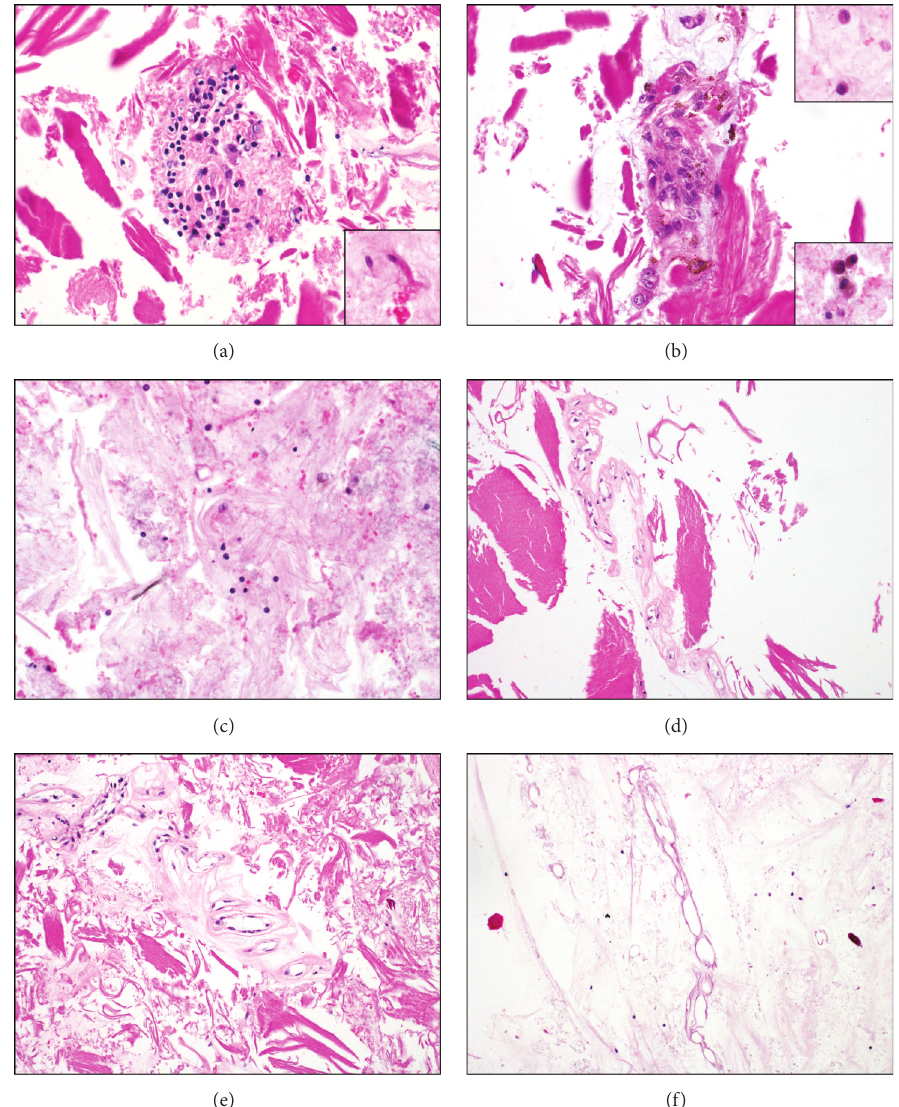
Figure 2: (a) Fragments of a group of spindle cells in type 2 matrix background. Inset shows isolated spindle cells (H&E, 40x). (b) Group of histiocytes and RPE cells in a granulomatous-like structure. Superior inset: isolated macrophages; inferior inset: isolated RPE cells (H&E, 40x). (c) Lymphocytes, neutrophils, and erythrocytes in type 1 matrix background (H&E, 40x). (d) Blood vessels with endothelial cell lining (H&E, 20x). (e) Aneurismatic dilation of a vessel (H&E, 20x). (f) Blood vessel without endothelial lining (ghost vessels; H&E,